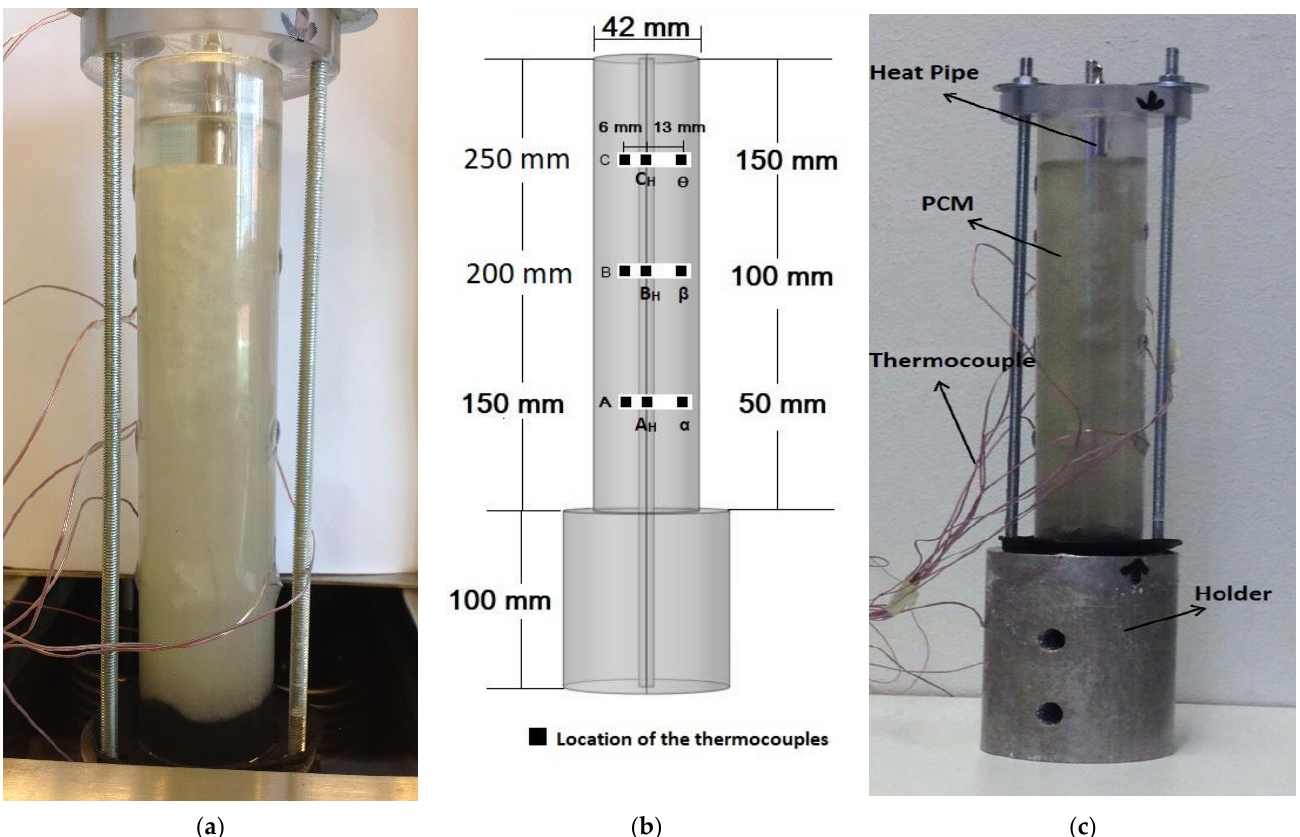
Figure 1. ( a ) The picture of testing inside the thermal bath, ( b ) location of the thermocouples, and ( c ) picture of the test setup.